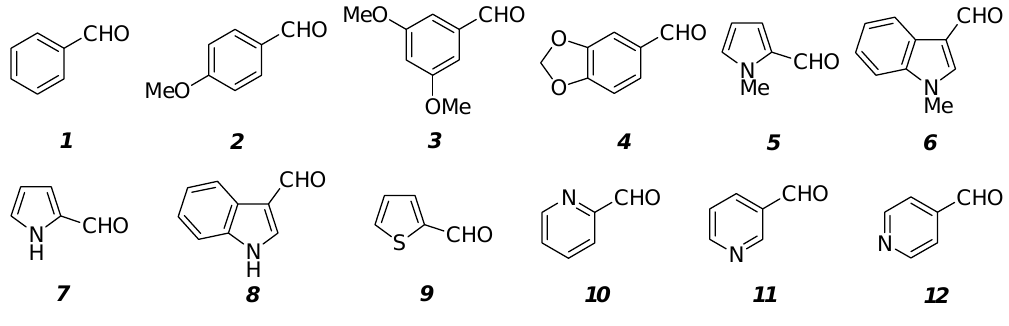
Figure 2. Aromatic aldehydes 10 { 1 – 12 } used for the Knoevenagel